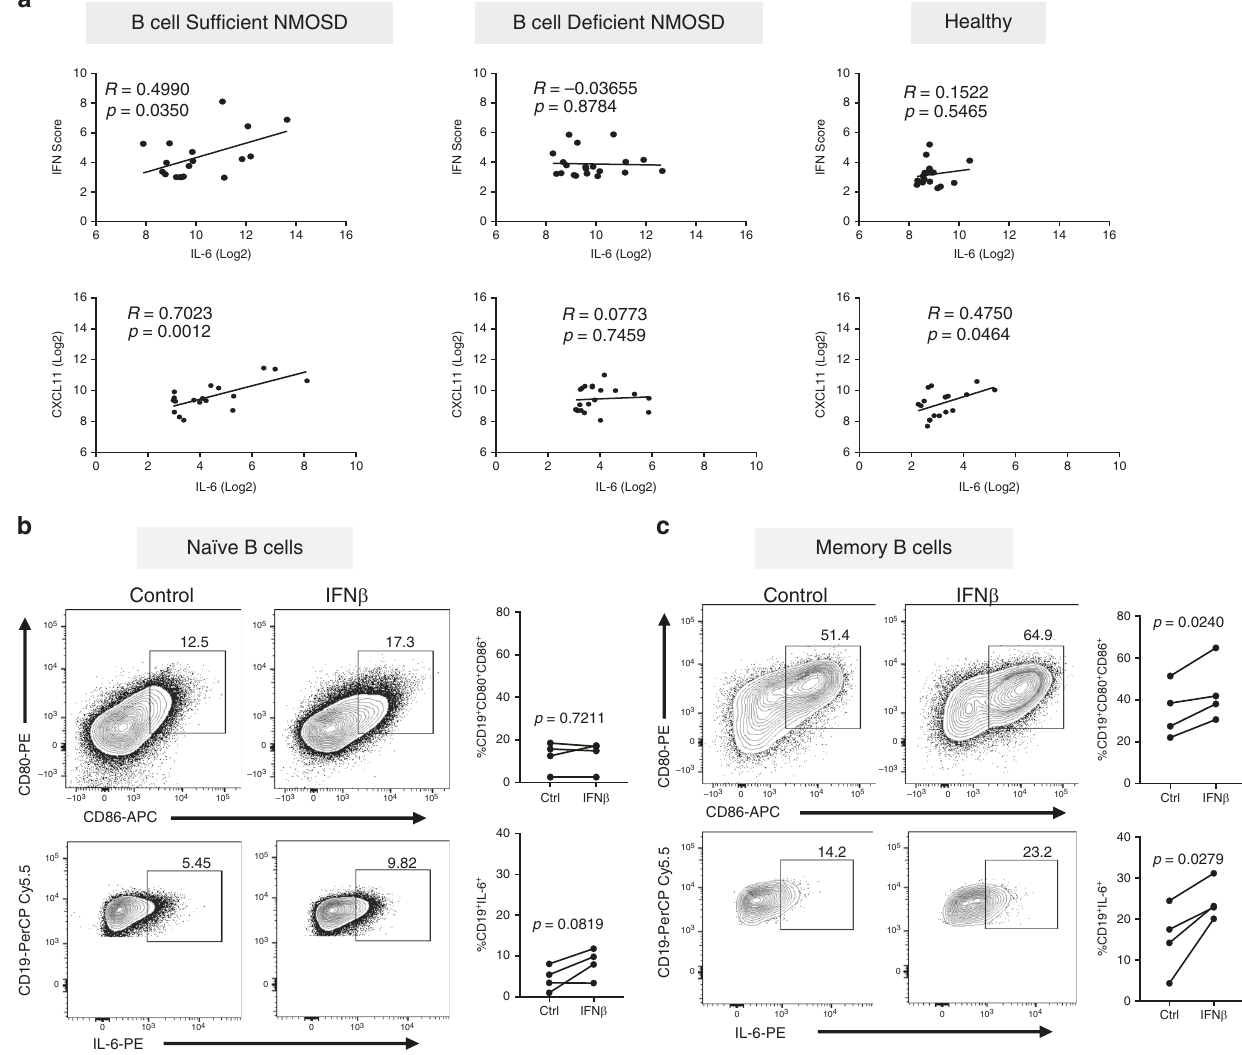
Fig. 5 Type I IFN drives IL-6 production in human memory B cells. a Correlation between composite IFN scores and serum CXCL11 levels with IL-6 in B cell-suf fi cient NMOSD patients ( n = 18), B-cell-de fi cient NMOSD patients ( n = 20) and healthy volunteers ( n = 18). R and p values were determined using two-tailed Pearson correlation coef fi cient tests. Direct effect of IFN- β on human naive and memory B cells was assessed by stimulating puri fi ed human naïve (CD27 − ) and memory B cells (CD27 + ) from healthy donors ( n = 4) with CD40L, anti-Ig ± IFN- β . Representative fl ow cytometric plots and frequency of live b naive CD19 + B cells and c memory B cells expressing CD80, CD86, and IL-6 are shown. Statistical signi fi cance was determined using two-tailed Student t tests. P values <0.05 were considered signi fi